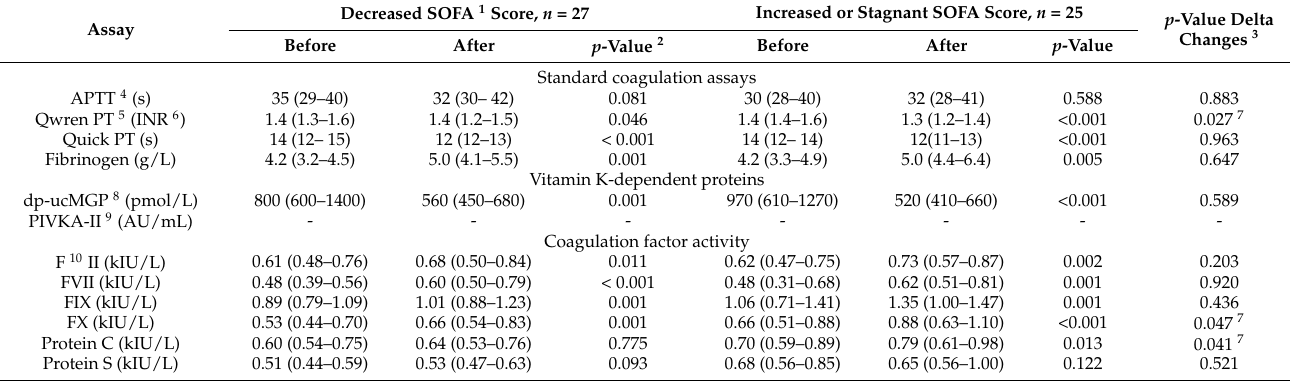
Table 3. Sensitivity analysis with a split dataset based on decreased or increased SOFA score. Decreased SOFA 1 Score, n = Assay